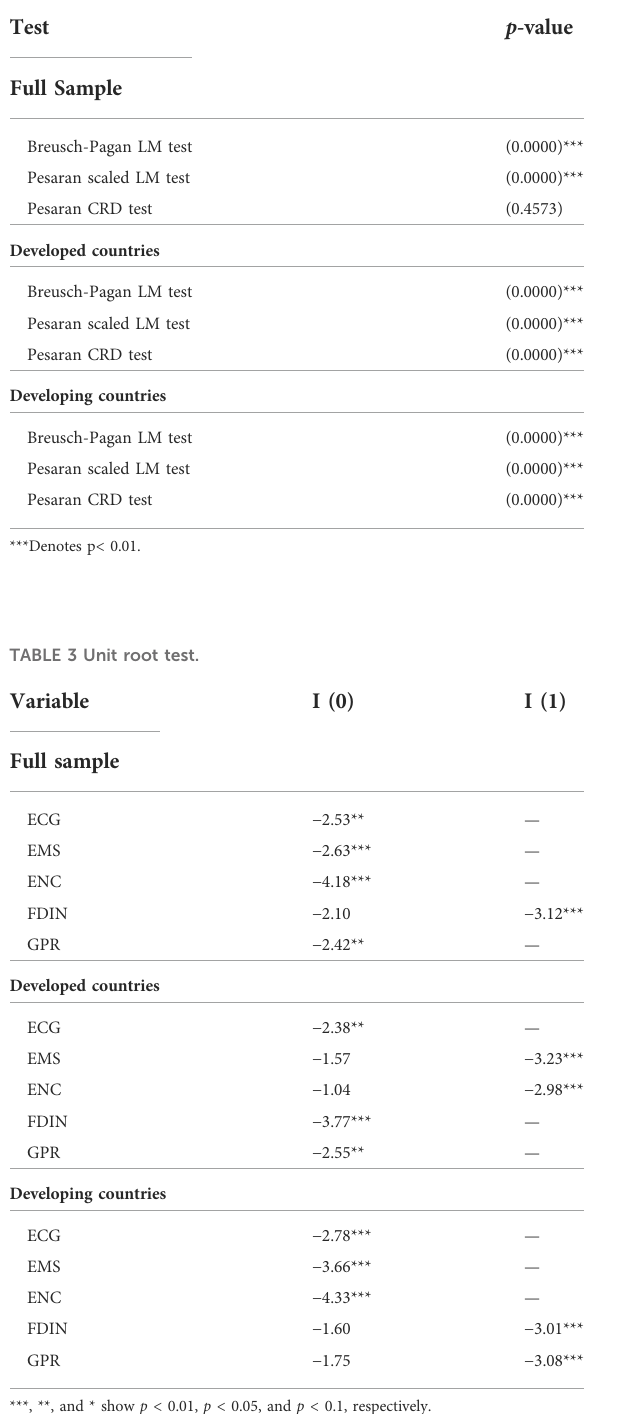
TABLE 4 Testing co − integration.